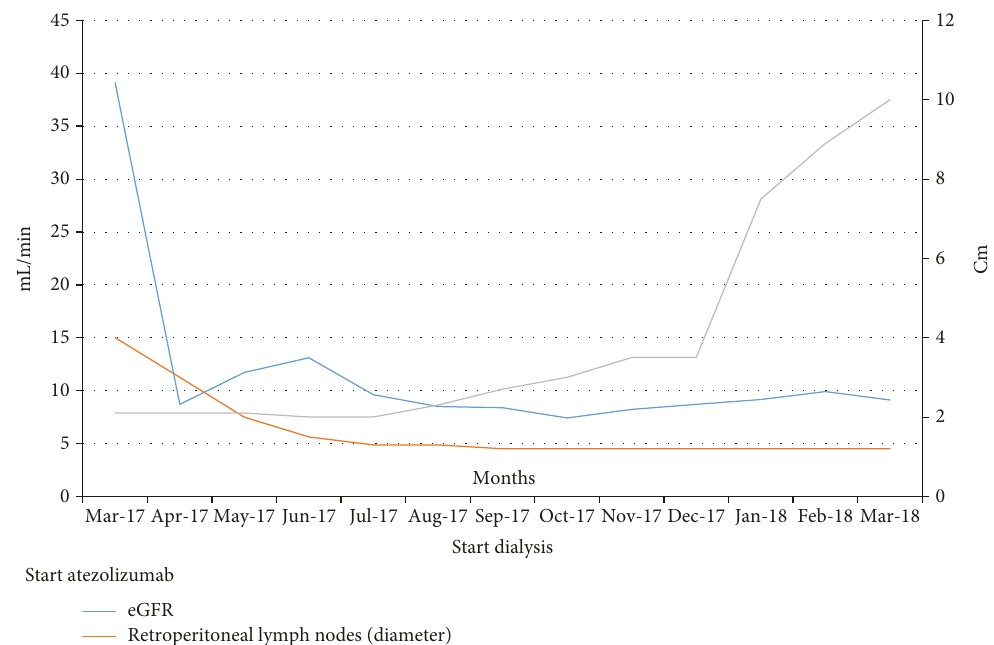
Figure 1: Timeline with the estimated glomerular fi ltration rate (eGFR) and diameters of target lymph nodal metastases.